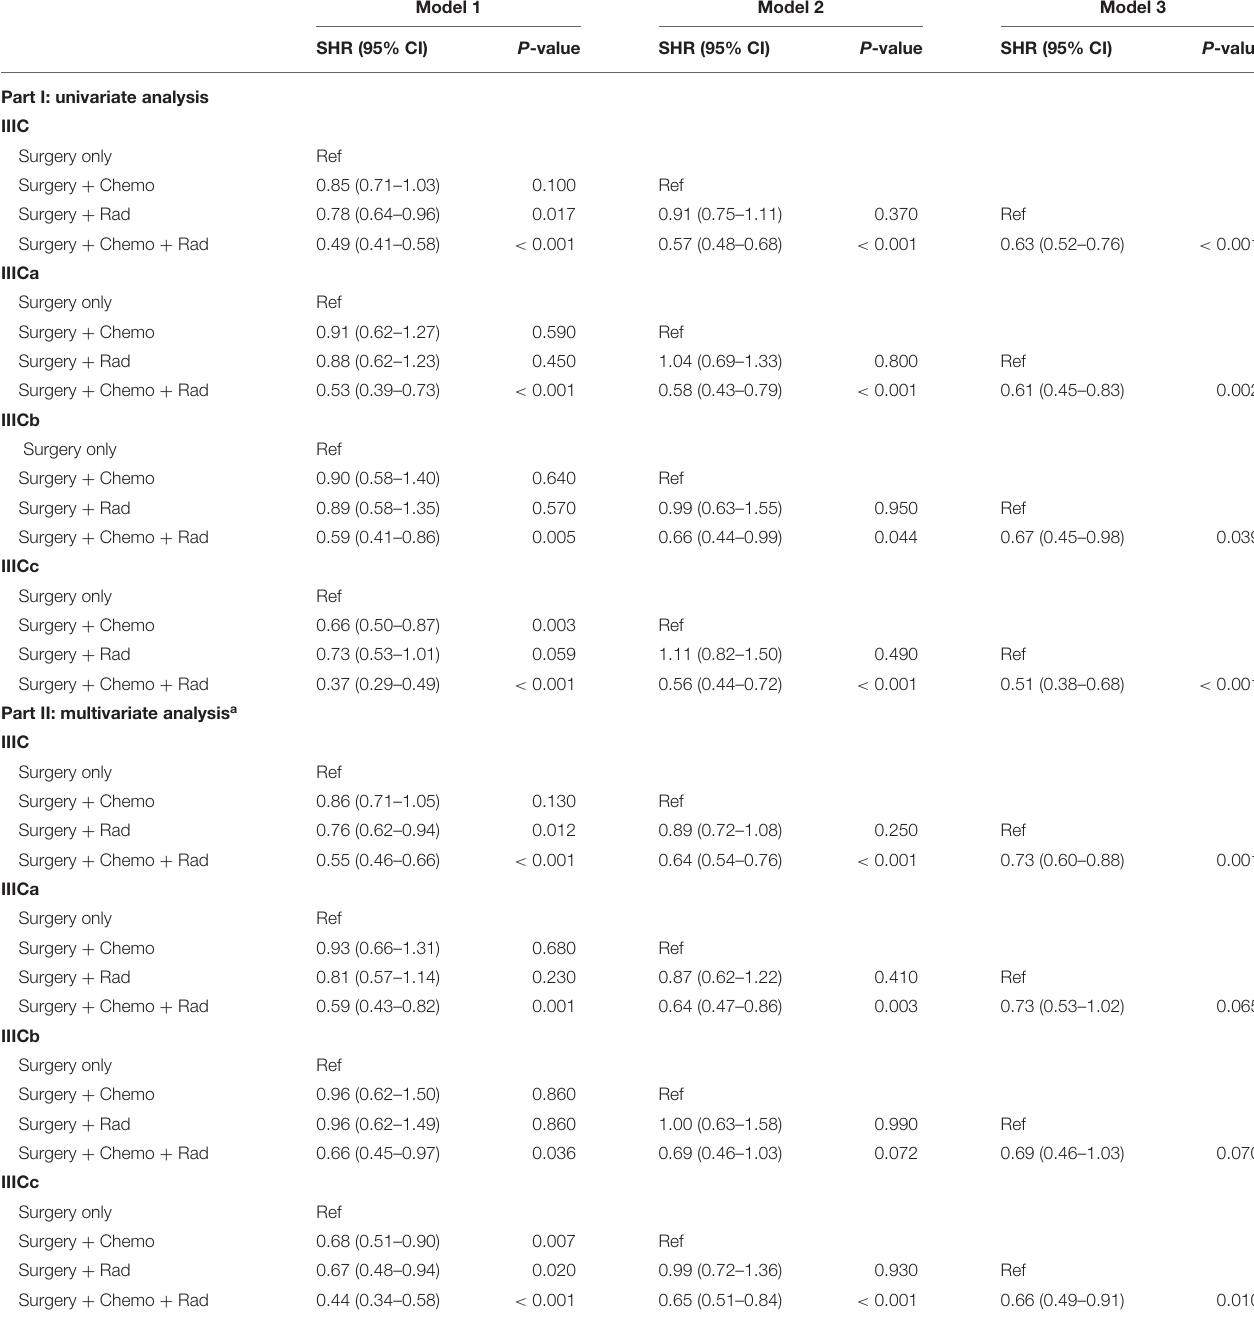
TABLE 4 | Association of cancer-specific mortality with treatment